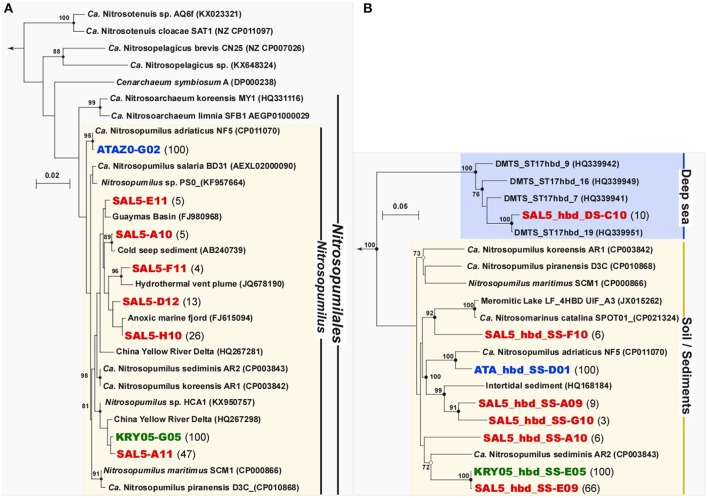
Phylogenetic affiliation of the archaeal 16S rRNA (A) and putative 4-hydroxybutyryl-CoA dehydratases 4-HBD (B) gene sequences, retrieved from three stably nitrifying enrichments ATA, KRY and SAL5. The tree was constructed using MacVector 11.1.2 software by Neighbor-Joining method and Jukes–Cantor distance matrix. Non-parametric bootstrapping was performed upon 1,000 iterations to infer tree topology and the nodes with the percentage of bootstrap re-sampling above 70% are indicated. The 16S phylogenetic tree was rooted with Haloferax lucentense 16S ribosomal RNA gene (AH003665), while the 4-hbd tree was out-grouped with 3-hydroxybutyryl-CoA dehydrogenase of N. maritimus SCM1 (Nmar_1028, ABX12924). The frequencies of all phylotypes of 16S rRNA and 4-hbd genes, present in clone libraries, are evidenced at the end of each sequence as percentage of analyzed clones. The scale bar represents the number of fixed mutations per nucleotide position.